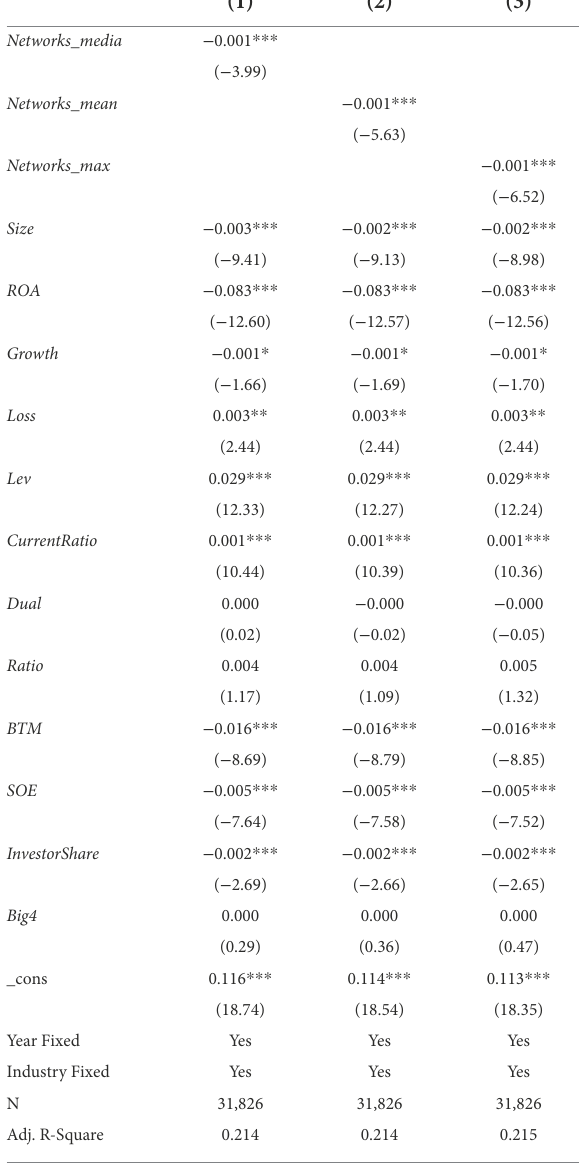
TABLE 4 Multivariate results for director networks and